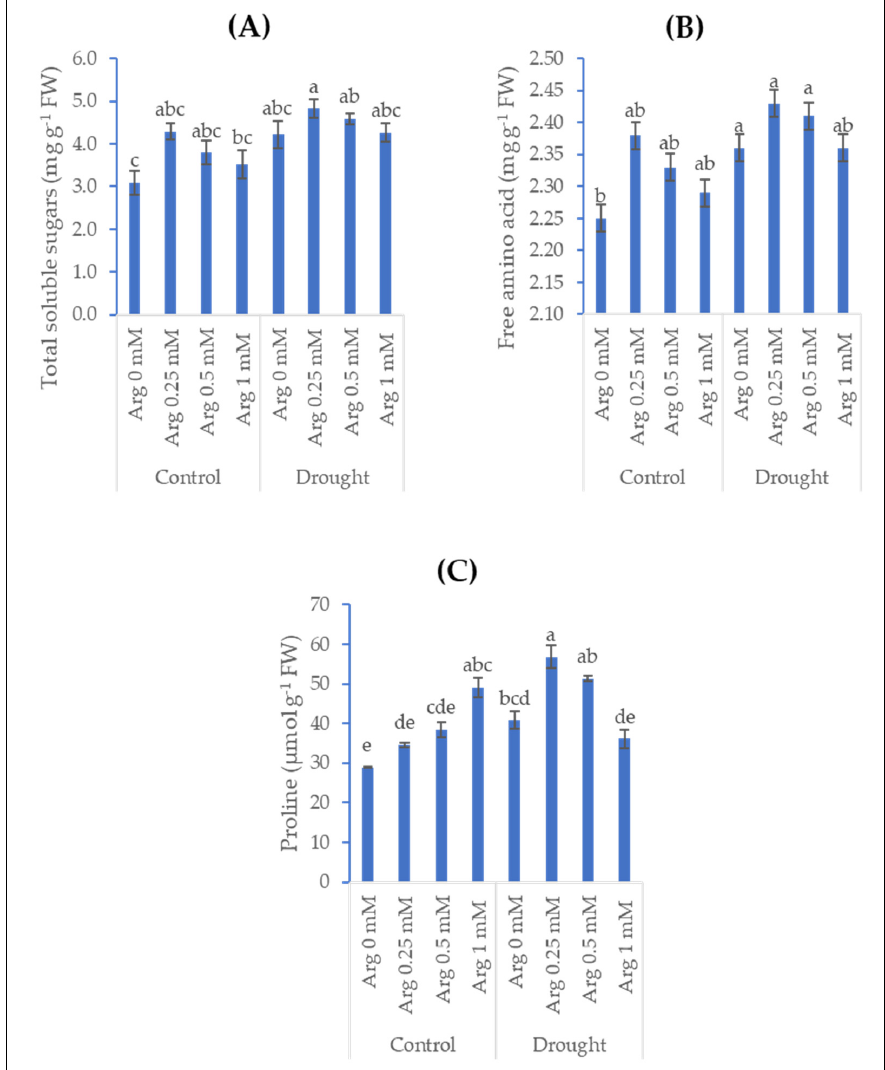
Figure 2. Effect of drought, arginine application, and their interactions on ( A ) soluble sugars, ( B ) free amino acids, and ( C ) proline content of wheat plants. Each bar represents mean ± standard error. Means that do not share the same letter are significantly different.